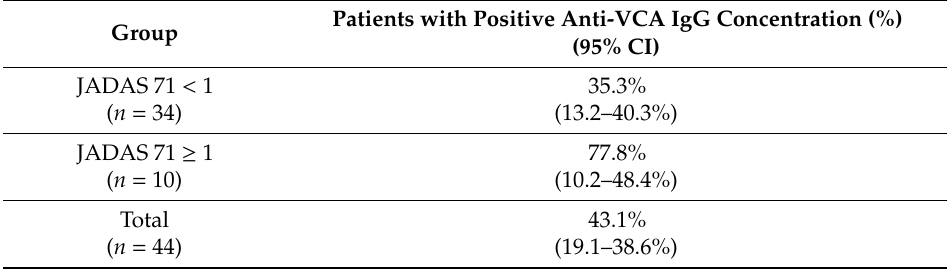
Table7. Prevalenceofpositiveanti-VCAIgGresults( > 1.1U / mL)inpatientswithinactive(JADAS 71 < 1) and active (JADAS 71 ≥ 1) disease; CI—confidence interval.